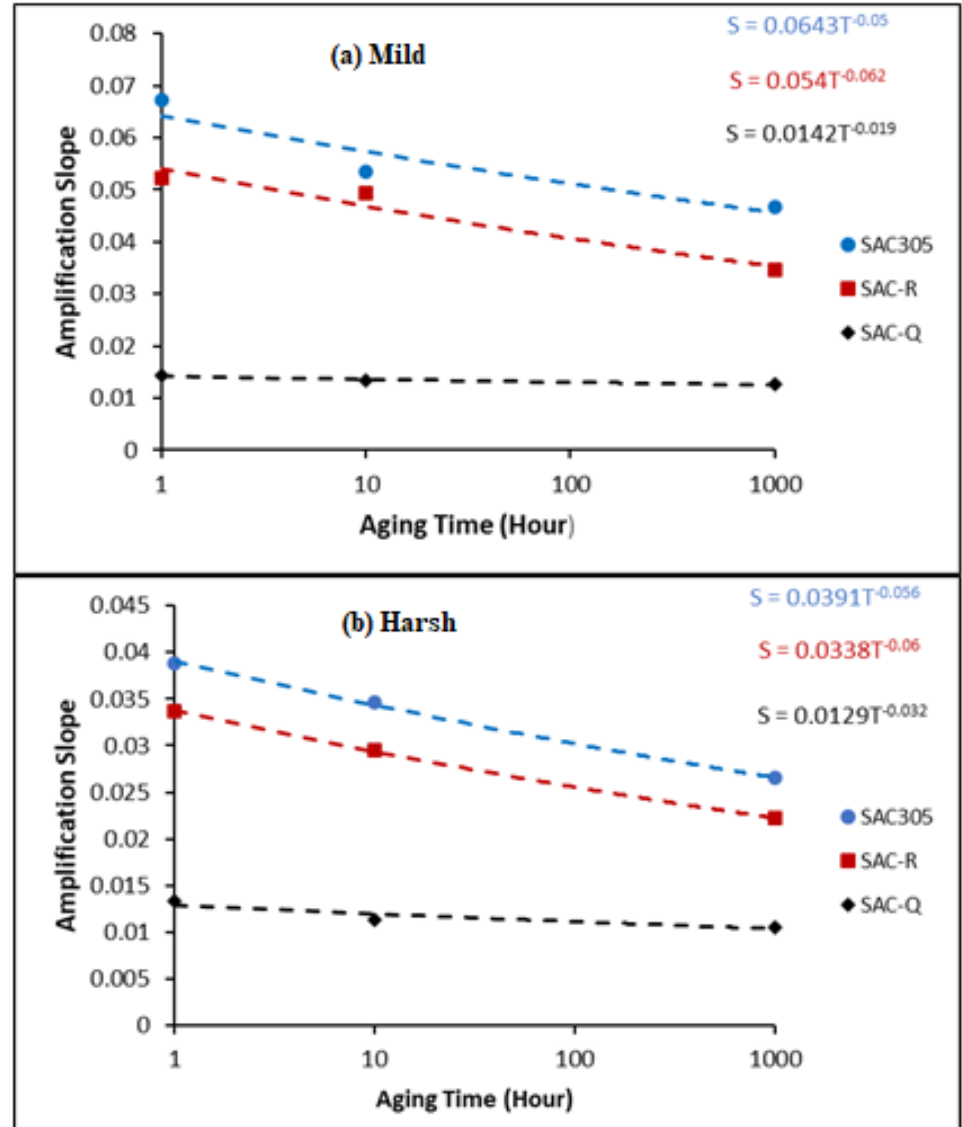
Figure 12. Confidence interval of ( a ) mild and ( b ) harsh amplification slope of non-aged, 10, and 1000 h aged SAC305 individual solder joint.